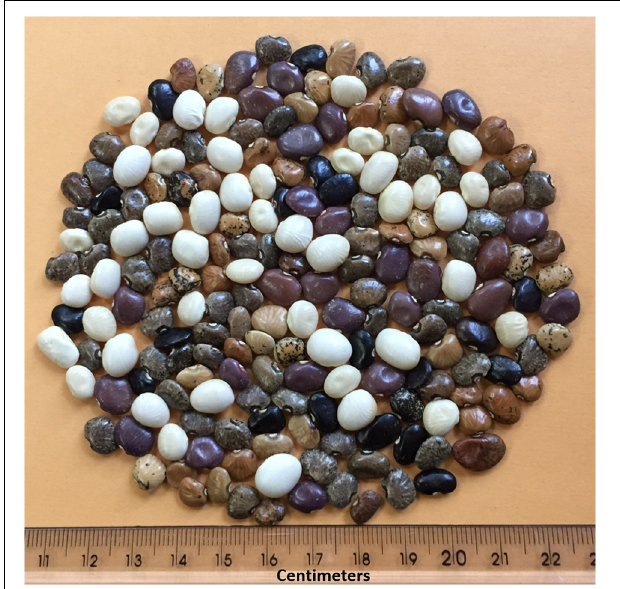
FIGURE 7 | Seeds collected in a wild-weedy-crop inter-reproductive complex located in a 2 year’s old milpa from Campeche, Mexico. In this milpa, only Sac-Ib landrace (with round-white seeds) was